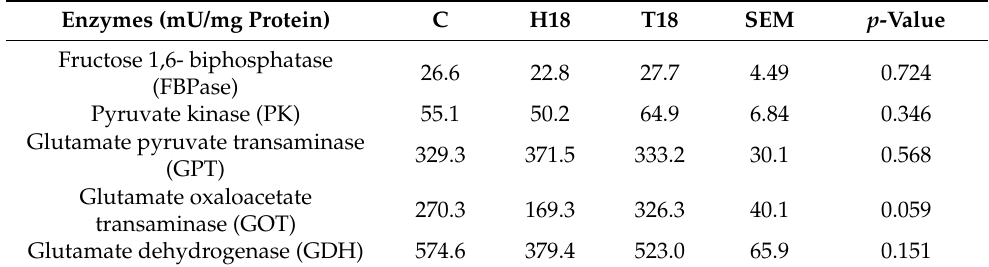
Table 5. Intermediary metabolism enzymes in liver of rainbow trout fed experimental diets.